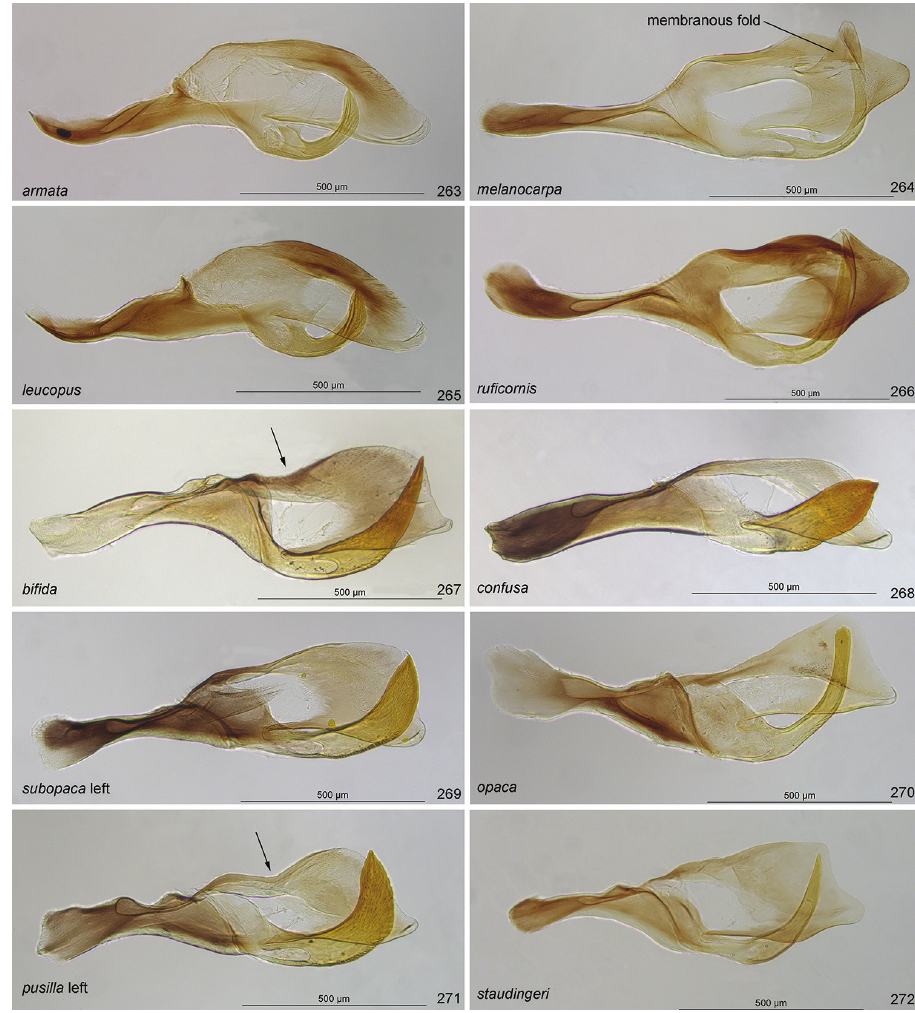
Figures 263–272. Penis valves of Pristiphora . 263 armata PR.465VV 264 melanocarpa PR.425VV 265 leucopus GBIF-GISHym3246, syntype of Nematus crassicornis Hartig 266 ruficornis PR.462VV 267 bifida DEI-GISHym80000 (arrow indicates a dorsal depression of the pseudoceps) 268 confusa DEI-GISHym31265 269 subopaca DEI-GISHym80030, left penis valve 270 opaca PR.459VV 271 pu- silla DEI-GISHym80029, left penis valve with strong dorsal depression of the pseudoceps (arrow) 272 staudingeri